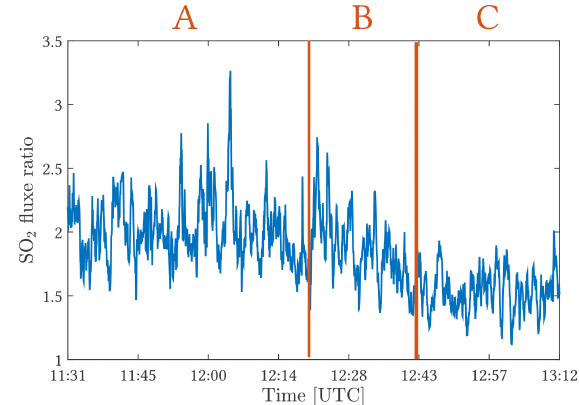
Figure 9. Deviations of the SO 2 fluxes of three different cross sec- tions through the plume. These apparent deviations are caused by the unknown inclination of the plume with respect to the image plane. This measurement set was taken at Mt Etna on the 9 July 2014.